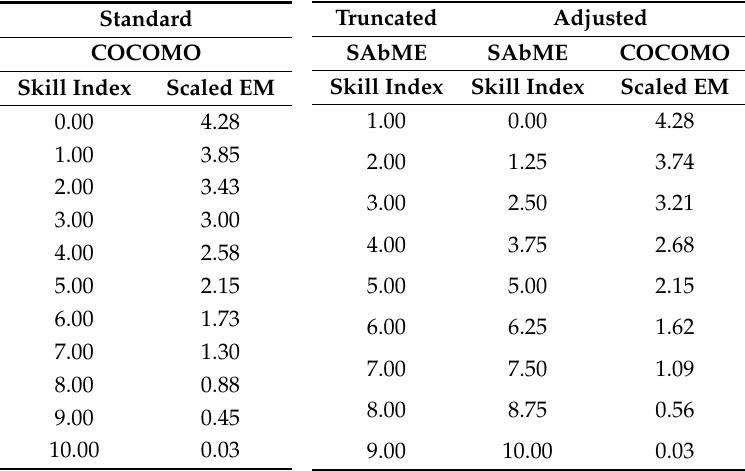
Table 8. Skill Index and COCOMO Regression Parameter E,